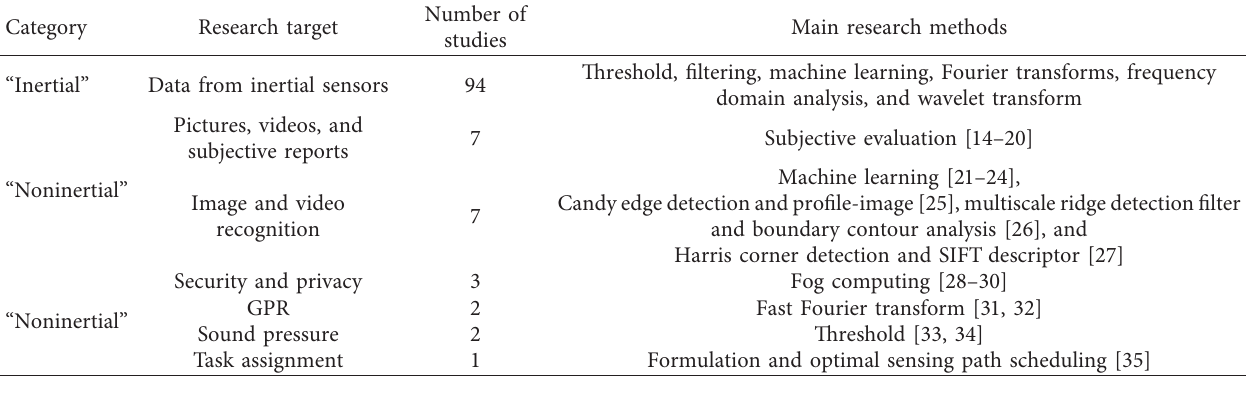
Table 2: Distribution of research topics and main research